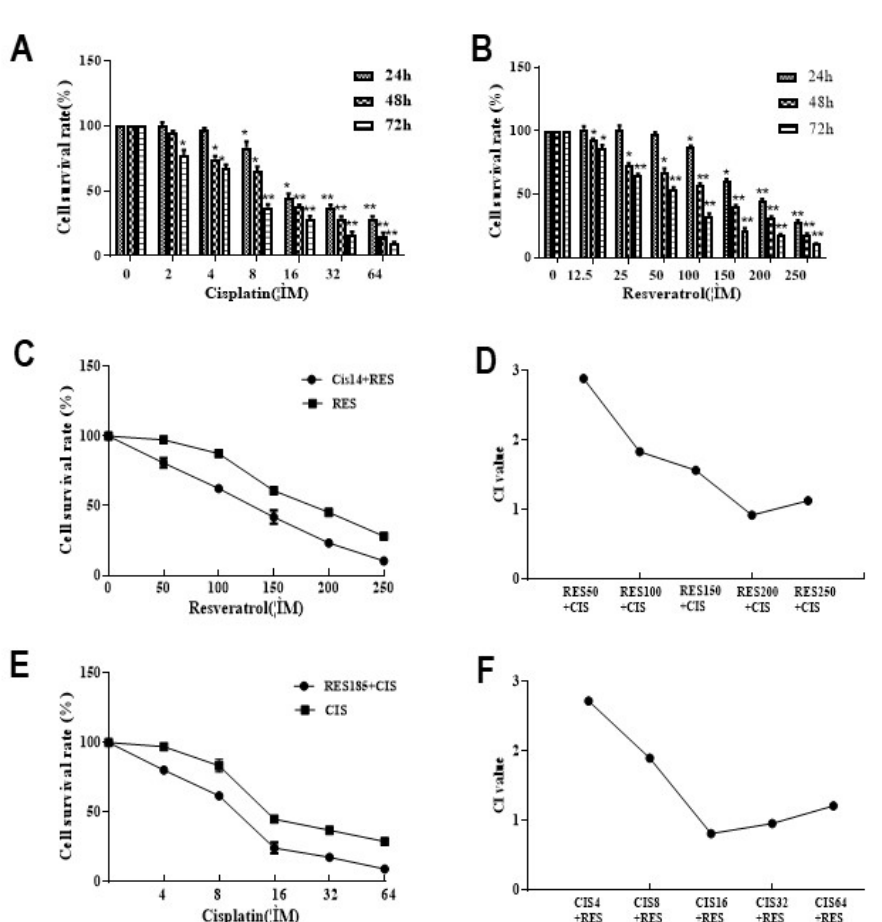
Figure 1. Effect of cisplatin and resveratrol on the viability of MDA231 cells. ( A ) Cell survival rate treated by cisplatin; ( B ) cell survival rate treated by resveratrol for 24, 48, and 72 h; ( C ) cell survival rate treated by 14 µ M cisplatin combined with different concentrations of resveratrol for 24 h; ( D ) CI value of cisplatin 14 μ M combined with resveratrol treatment; ( E ) cell survival rate treated by 185 μ M resveratrol combined with different concentrations of cisplatin for 24 h; ( F ) CI value of 185 μ M resveratrol combined with cisplatin treatment. The experiment was repeated three times, RES, resveratrol. CIS, cisplatin. * p < 0.05, ** p < 0.01, vs. the control group.